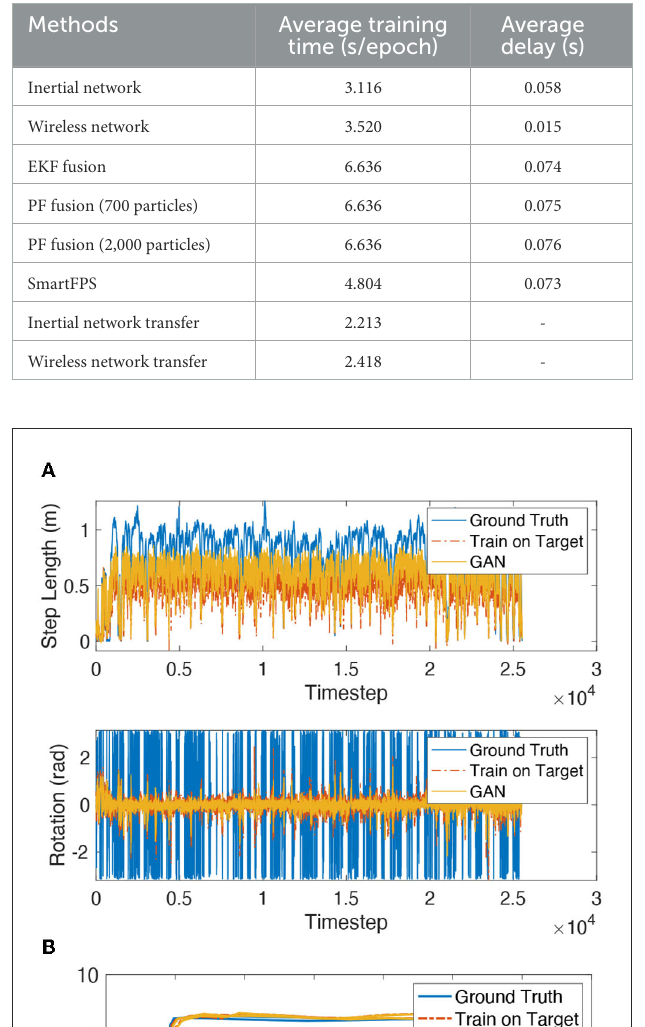
TABLE 3 Computation performance of filter methods and